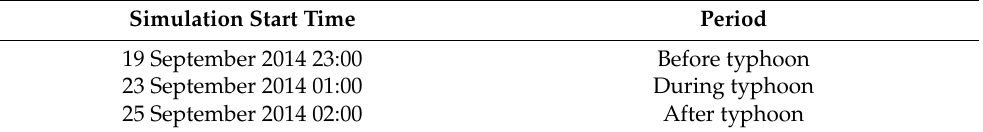
Table 3. Specific time interval of